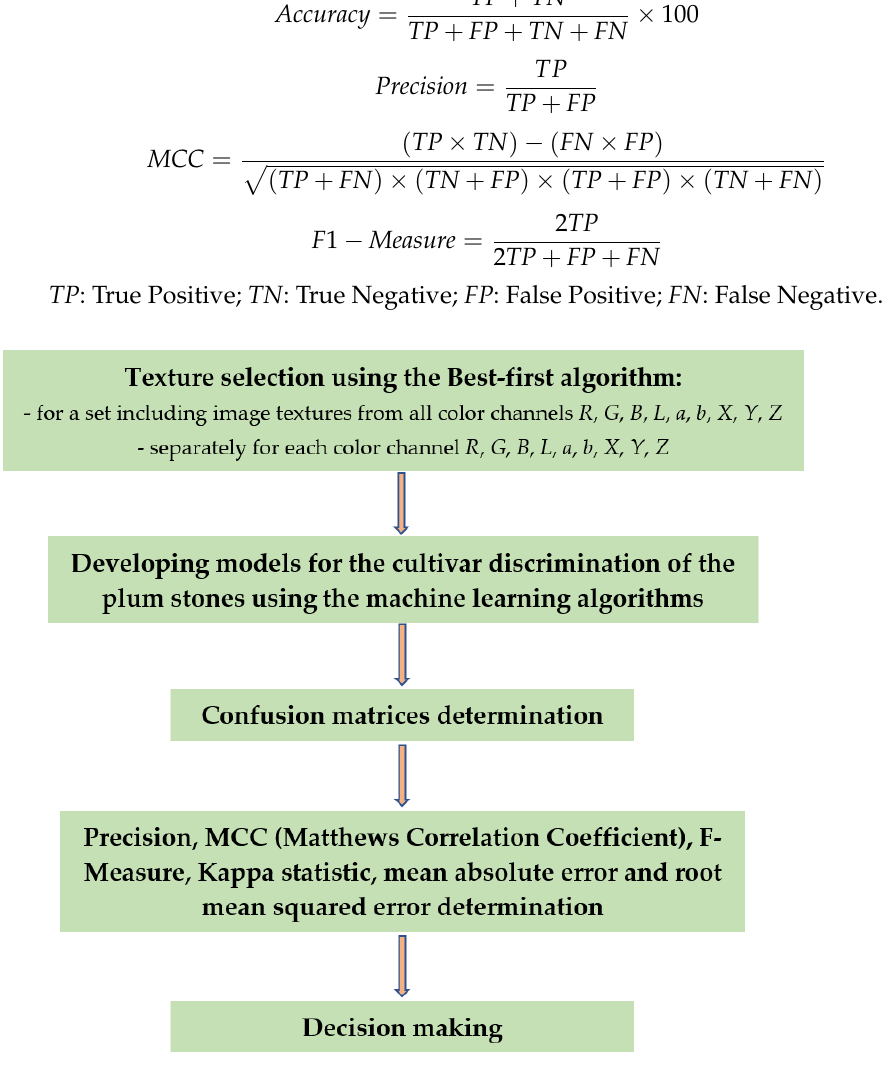
Figure 3. The steps for plum stone cultivar discrimination using the WEKA machine learning soft- ware.